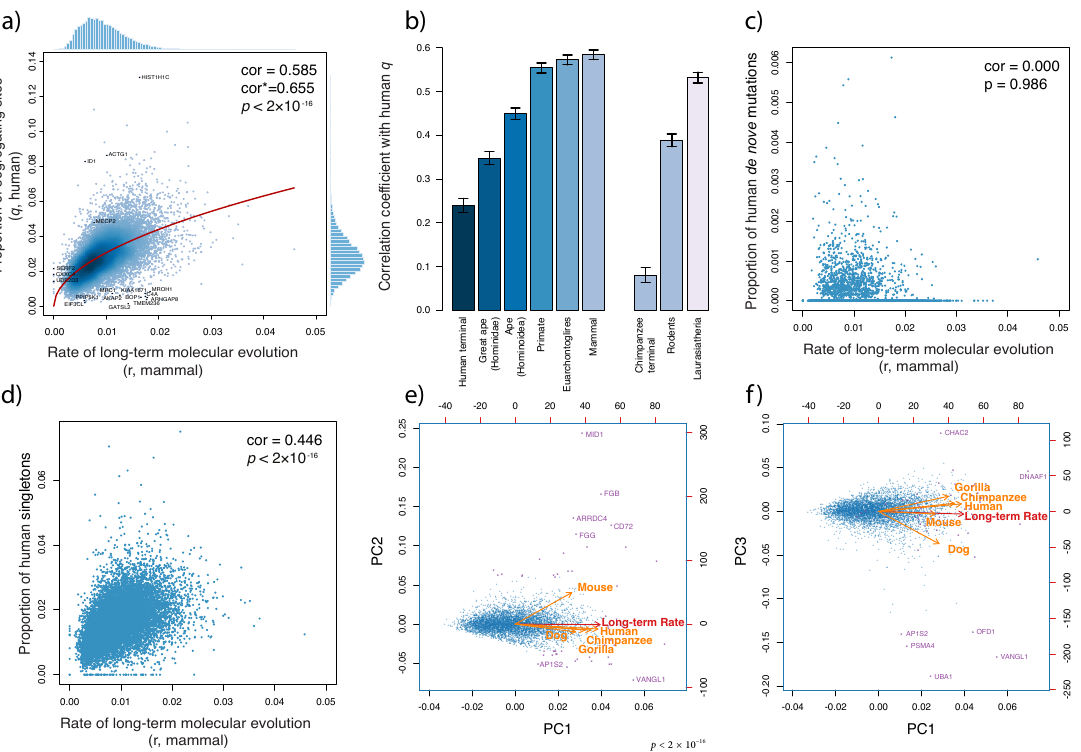
Figure 2. Bridging micro- and macroevolution at the molecular level: ( a ). Correlation between the human proportion of segregating sites (q) and the rate of mammalian molecular evolution (r) of 14,671 genes. cor* indicates the bias-corrected correlation. ( b ). Correlation between the human proportion of segregating sites (q) and the rate of molecular evolution (r) based on gene trees of different taxonomic clades. ( c ). Correlation between the proportion of human de novo mutations and the rate of mammalian molecular evolution (r). ( d ). Correlation between the proportion of human singletons and the rate of mammalian molecular evolution (r). ( e , f ). Principal component analysis (PCA) of q of five species and the long-term rate using 5560 single-copy